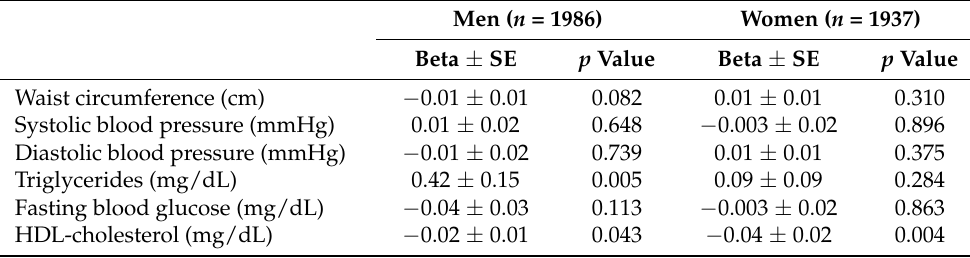
Table 5. Association of carbohydrate intake (g/1000 kcal per day) with metabolic syndrome